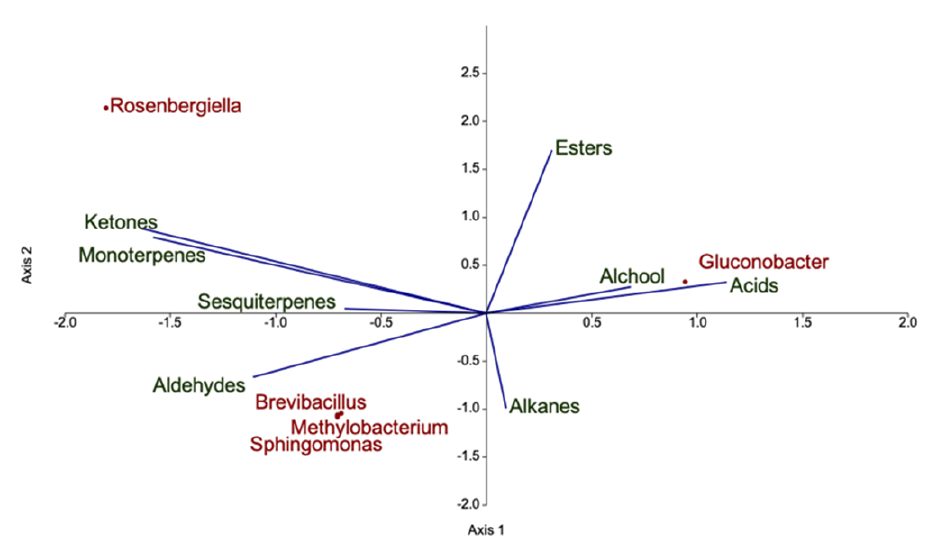
Figure 7. Canonical correlation analysis of bacterial genera discriminating organic from IMP grown fruit and volatile organic compounds classes. Bacterial genera are coloured in brown, volatile organic compounds classes in green.